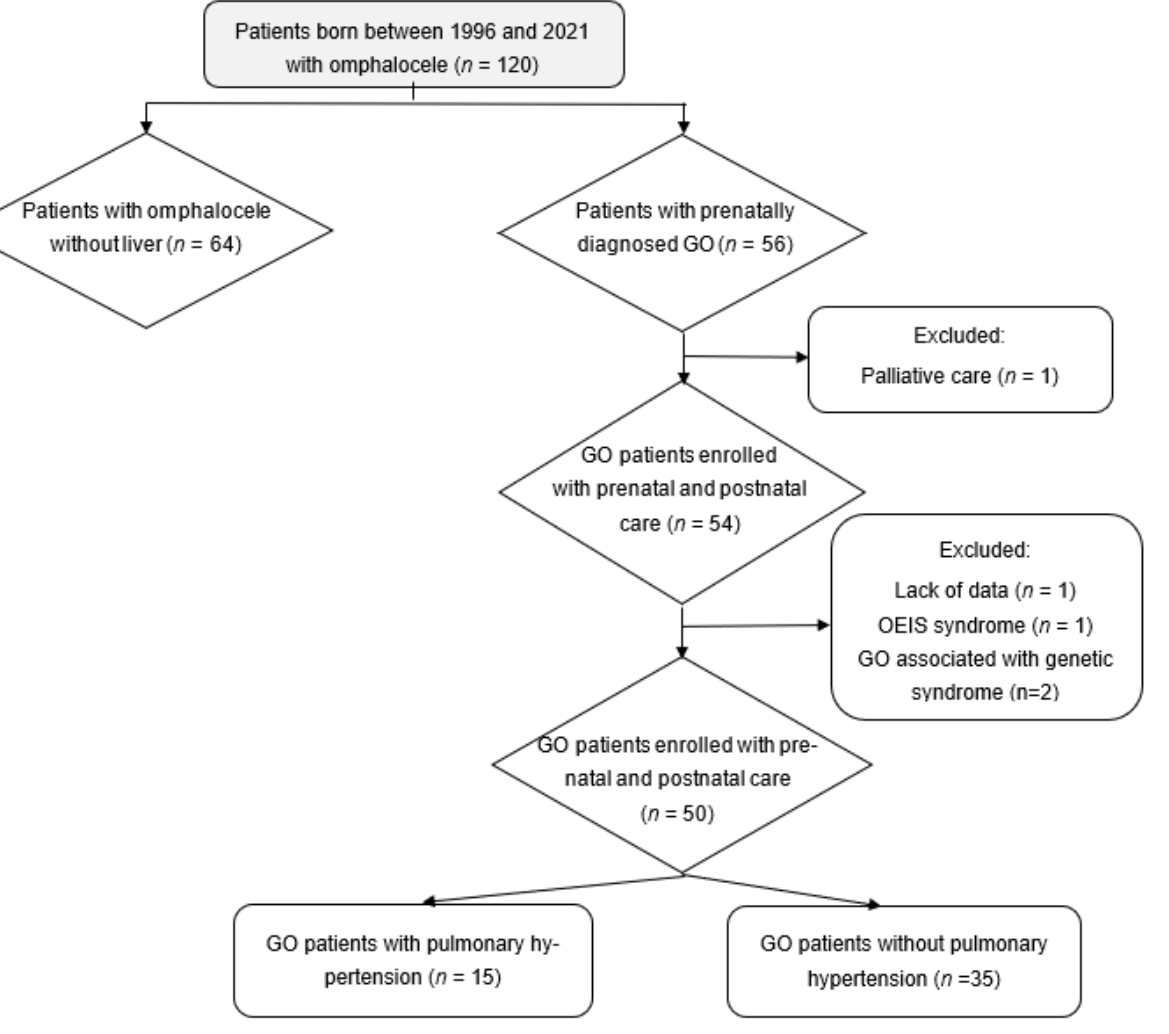
Figure 1. Flow chart of the study population. Abbreviation: GO, giant omphalocele, OEIS, omphalocele-cloacal exstrophy syndrome. Table 1. Antenatal characteristics.